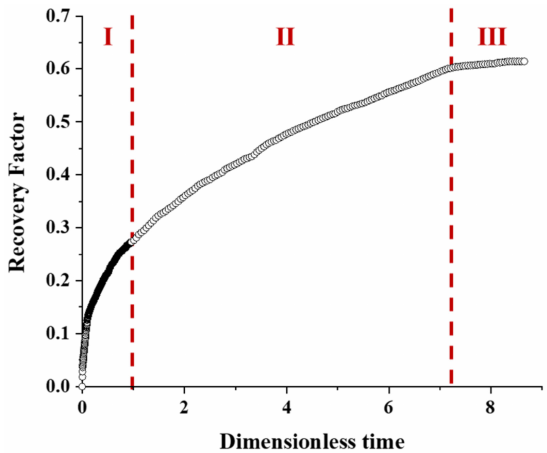
Figure 12. Recovery factor at different